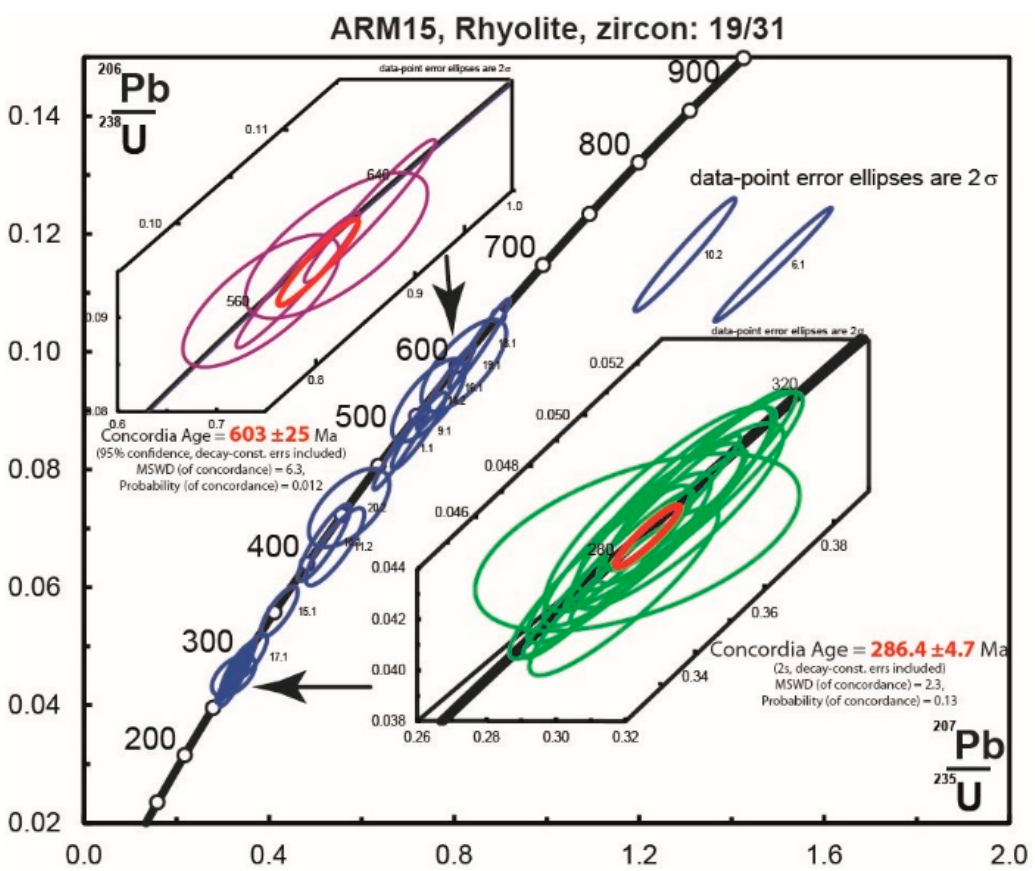
Figure 14. Zircon U–Pb SHRIMP geochronology. Wetherill Concordia plots of U–Pb zircon data for the rhyolitic sample